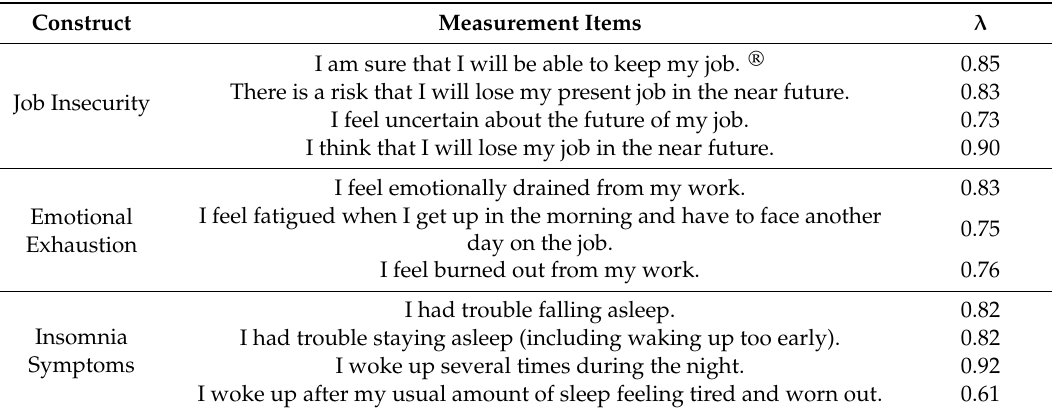
Table 1. The measurement scales results of confirmatory factor